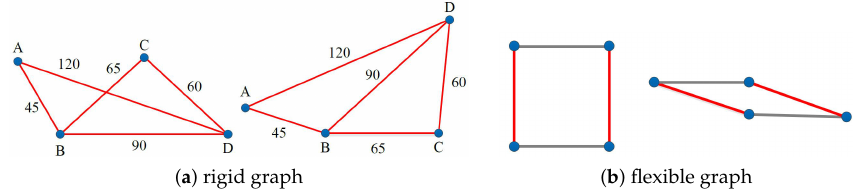
Figure 1. Frameworks of a rigid graph and a flexible graph.